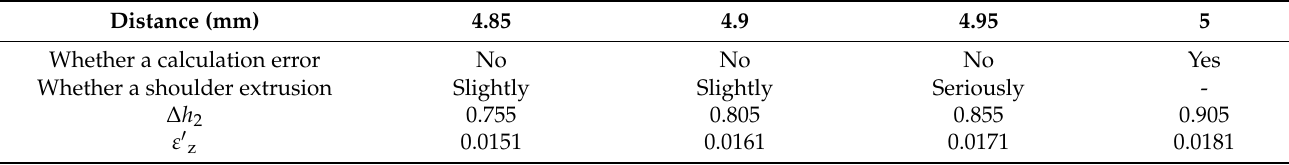
Table 5. Finite element simulation